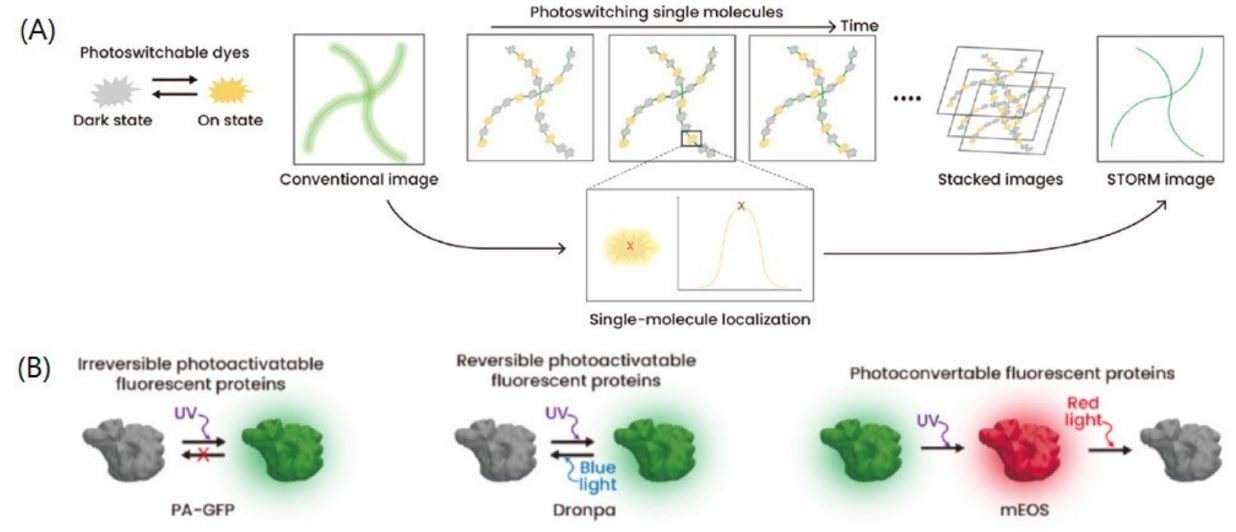
Figure 1. Single-molecule localization microscopy (SMLM). ( A , B ) The principles of ( A ) STORM and ( B ) PALM. Adapted from the article of [8] under Creative Commons Attribution (CC BY)